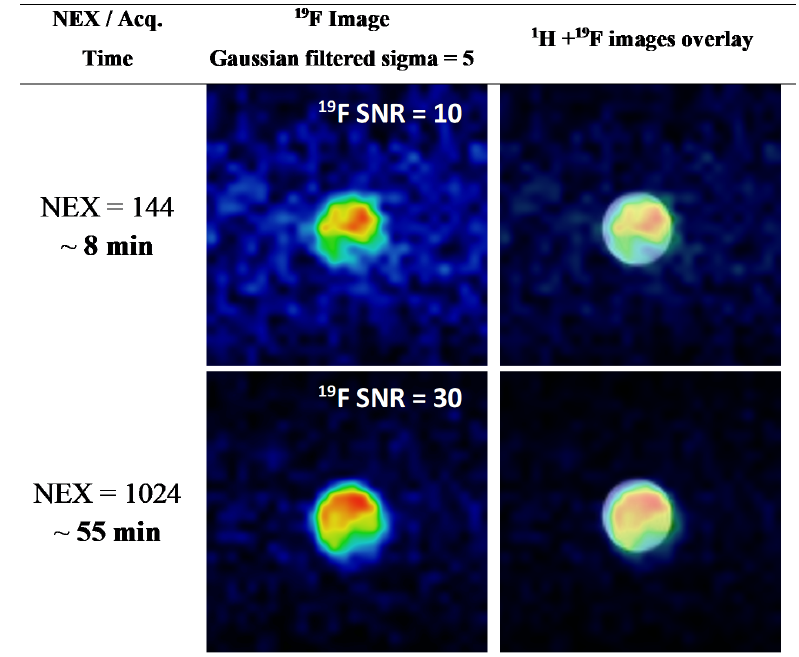
Figure 5. 19 F images of the sample containing nanocarriers loaded with 5-fluorouracil (5-FU NC 1 PGA).